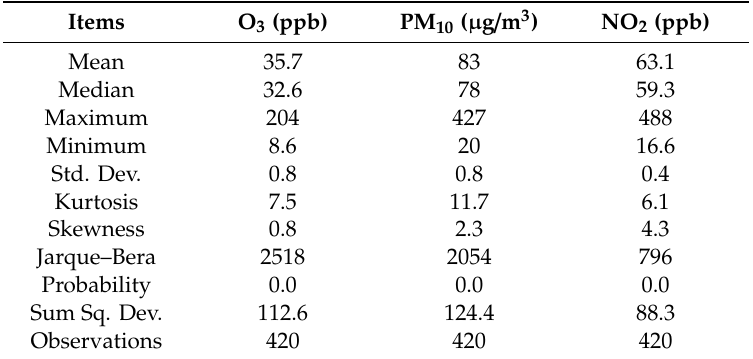
Table 1. Basic properties of the three pollutants in the photochemical pollution factor.